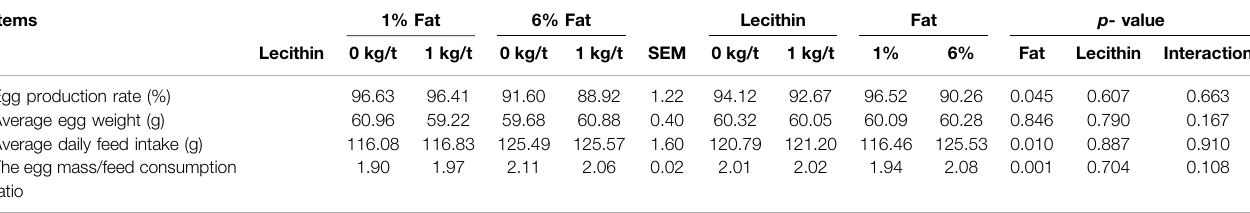
TABLE 2 | Effect of adding lecithin on egg laying performance of laying hens on 35 days.